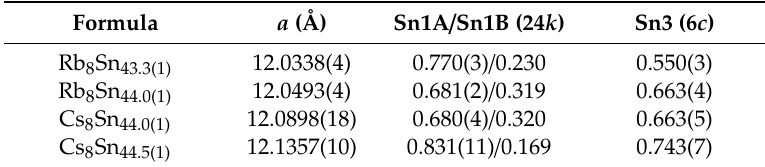
Table 4. Refined compositions, corresponding unit cell parameters, and occupancies on Sn 24 k and 6